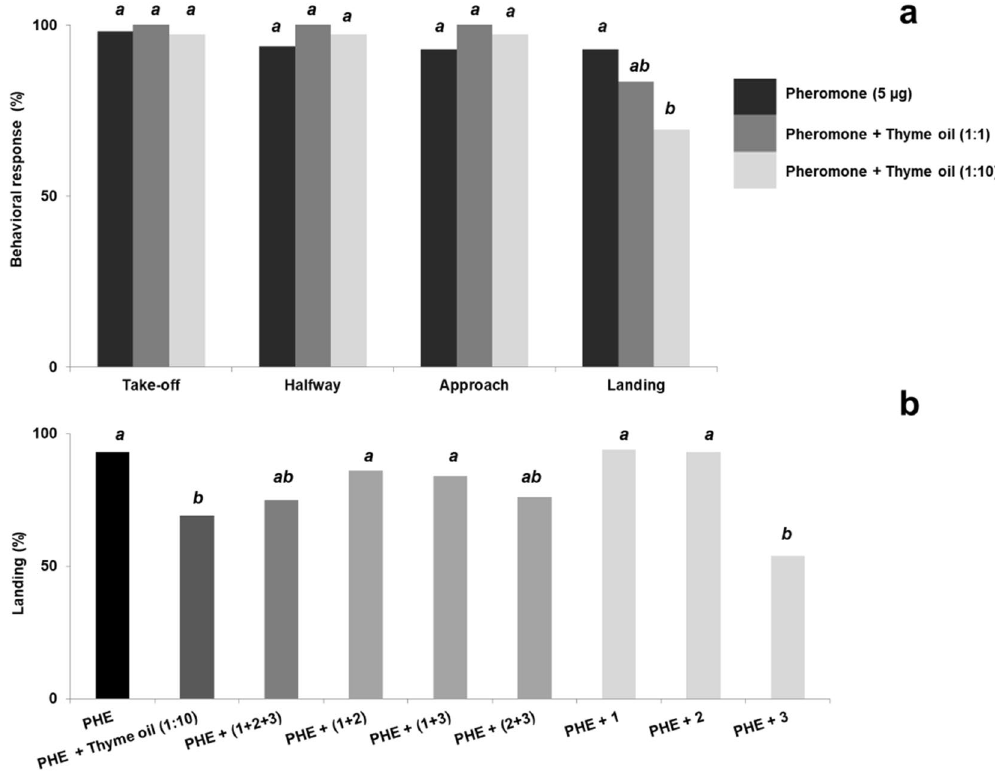
Figure 4. Sequential behavioral steps of G. molesta males in response to sex pheromone alone (PHE: 5 µg of Z 8-12:OAc + E 8-12:OAc + Z 8-12:OH in 100:6:10 ratio) (n = 60), and co-released with thyme oil in 1:1 and 1:10 ratios (n = 30) ( a ); Landing percentage of males subjected to mixtures of PHE + thyme oil (1:10), PHE + p -cymene (15 µg) ( 1 ), PHE + carvacrol (1.5 µg) ( 2 ), PHE + thymol (22.5 µg) ( 3 ), and PHE + binary/ternary blends of thyme oil components (n = 30 for each test) ( b ). Bars with different letters are significantly different (Chi-square 2 × 2 test of independence with Yates’ correction, at α =